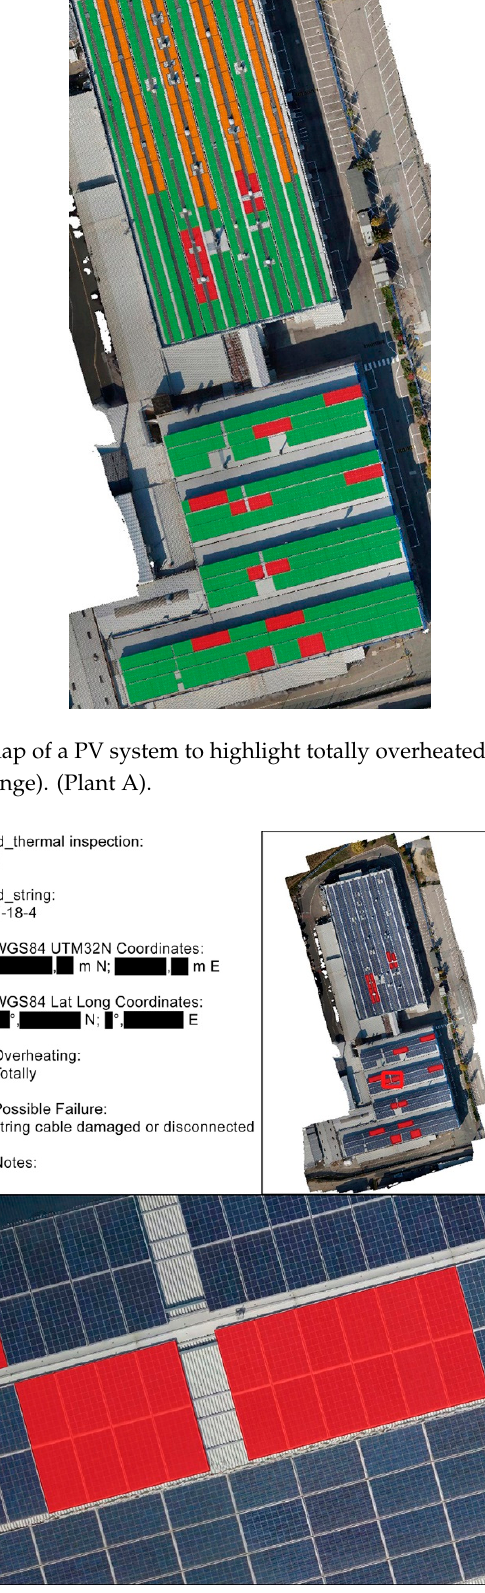
Figure 17. Example of a report page generated using the atlas function of QGIS. (Plant A).